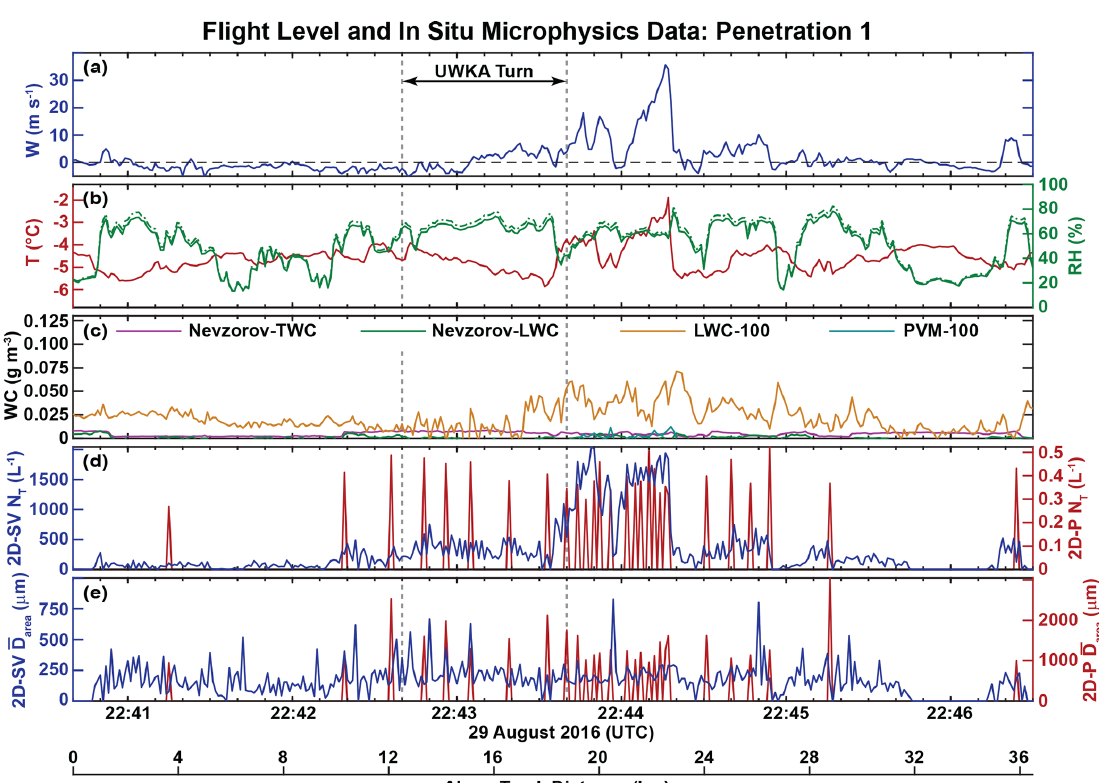
Figure 4. UWKA flight-level and in situ microphysics data for penetration 1 (Fig. 1d, Table 2). (a) Vertical air velocity (blue), (b) temperature (red), relative humidity with respect to liquid (solid green) and relative humidity with respect to ice (dashed green), (c) bulk water content (WC) from the Nevzorov TWC probe (magenta), Nevzorov LWC probe (green), LWC-100 probe (gold), and PVM-100 probe (cyan), (d) total concentration ( N T ) from the 2D-SV probe (blue) and 2D-P probe (red), and (e) area-weighted mean diameter ( D area ) from the 2D-SV probe (blue) and 2D-P probe (red). Along-track distance for the penetration shown at